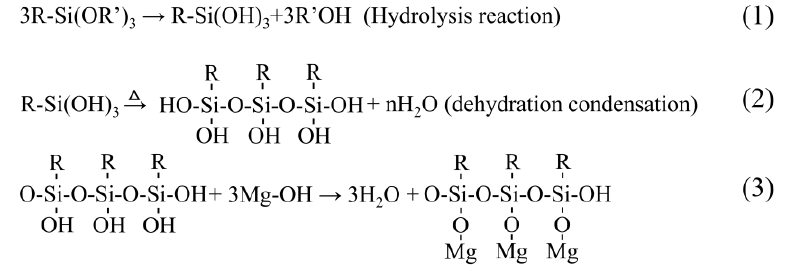
Figure 1. Schematic of silane coatings formation process. The first stage, siloxane hydrolysis: (1); In the second stage, dehydration condensation between silanol molecules: (2); In the third stage, the Si-OH bond is combined with the -OH on the Mg alloy: (3).